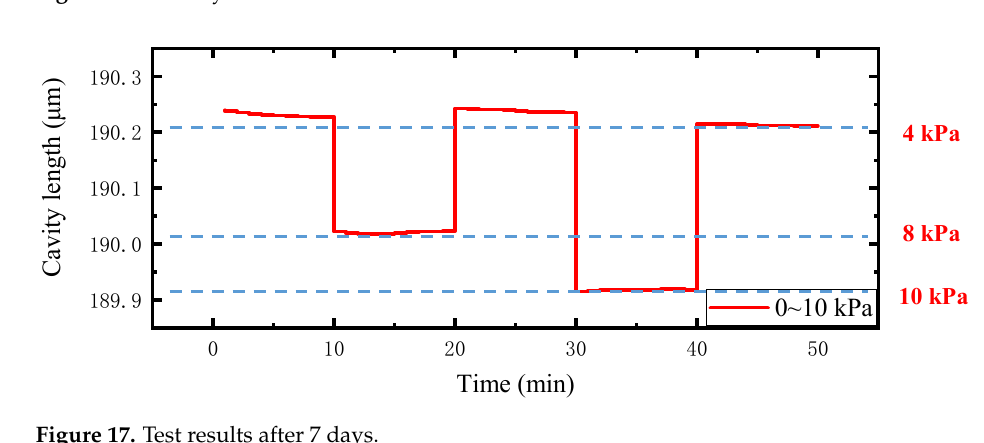
Figure 17. Test results after 7 days.